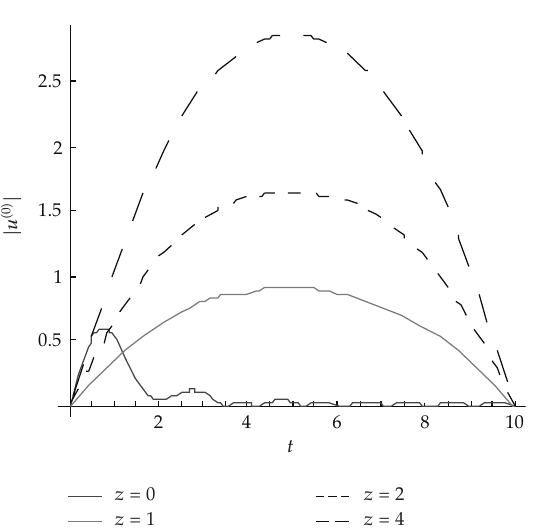
Figure 29: The zero-order approximation | u (cid:3) 0 (cid:4) | at α (cid:8) 1, T (cid:8) 10, γ (cid:8) 02 for di ff erent values of z , considering only one term in the series (cid:3) M (cid:8) 1 (cid:4) .